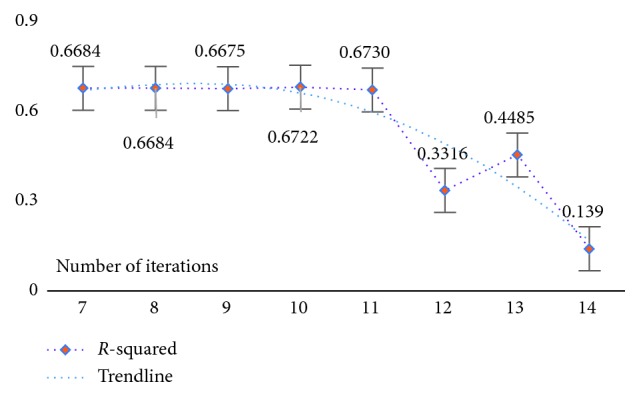
CCrime: R-squared.